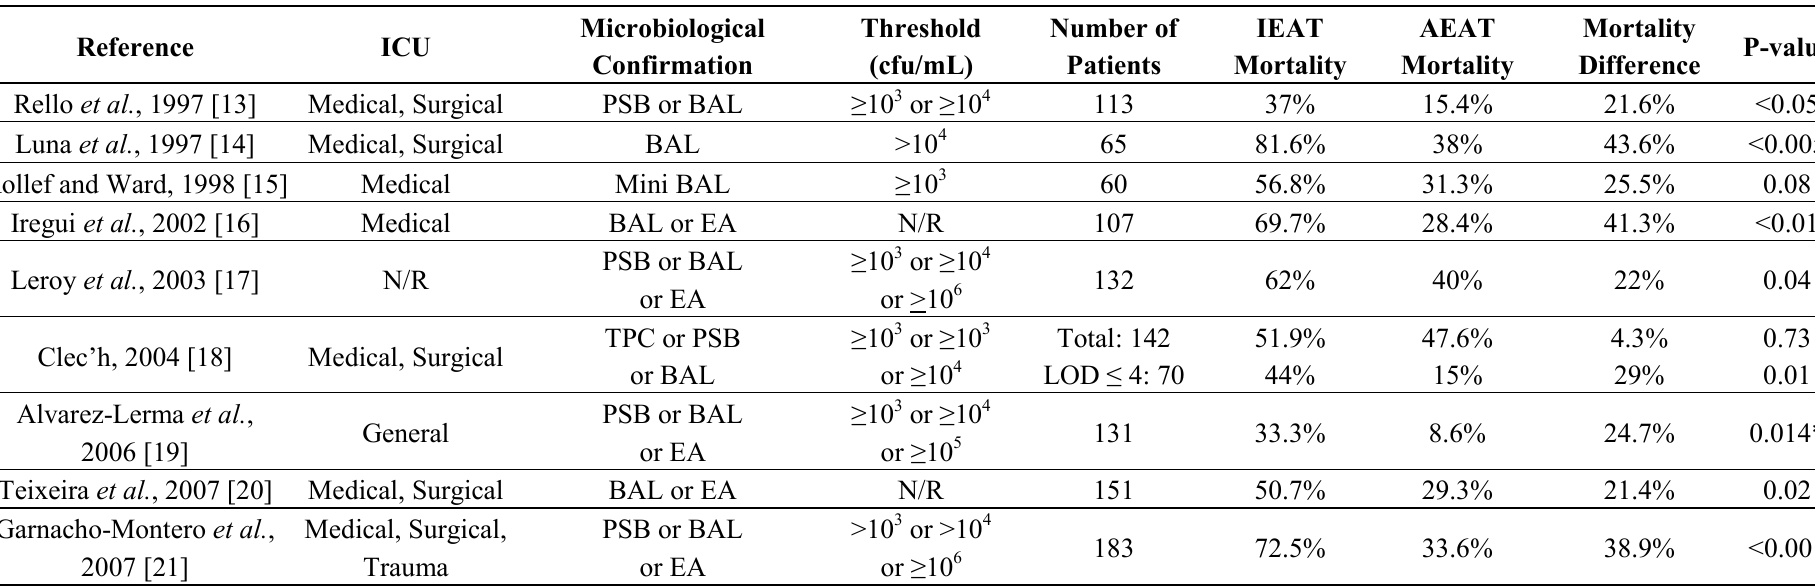
Table 1. Studies showing benefit of appropriate empiric